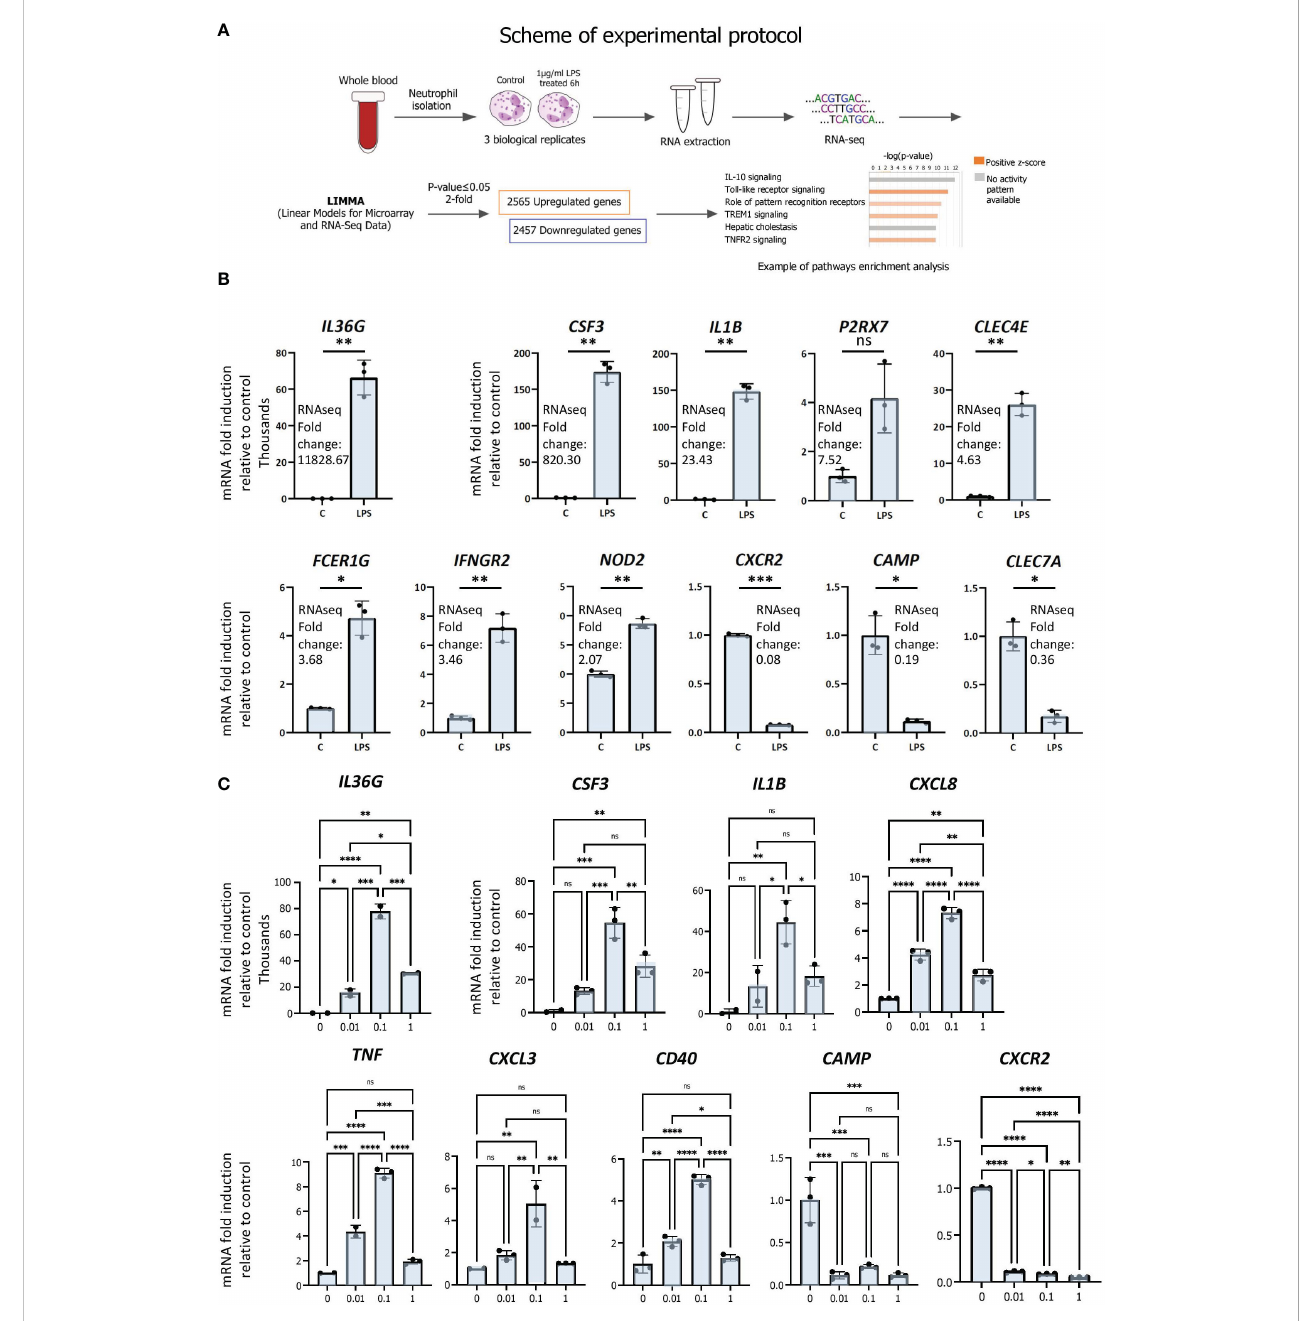
FIGURE 1 RNAseq analysis of primary human neutrophils. (A) Schematic representation of work fl ow for RNAseq analysis of LPS-regulated gene expression in neutrophils. (B) Validation of regulation by LPS of differentially expressed genes by RT/qPCR analysis. Data are representative of 2 or 3 biological replicates. *P ≤ 0.05, **P ≤ 0.01, ***P ≤ 0.001 and ns ≥ 0.05 as determined by paired Student ’ s t-test for technical replicates of one representative sample. (C) Dose-response curves of LPS. Primary human neutrophils were treated for 6h with 0 to 1 µg of LPS per ml and RT/qPCR was subsequently performed. Graphics are mean ± SD from 3 technical replicates and data are representative of 2 or 3 biological replicates. *P ≤ 0.05, **P ≤ 0.01, ***P ≤ 0.001, ****P ≤ 0.0001 and ns ≥ 0.05 as determined by one-way ANOVAs followed by Tukey ’ s post hoc test for multiple